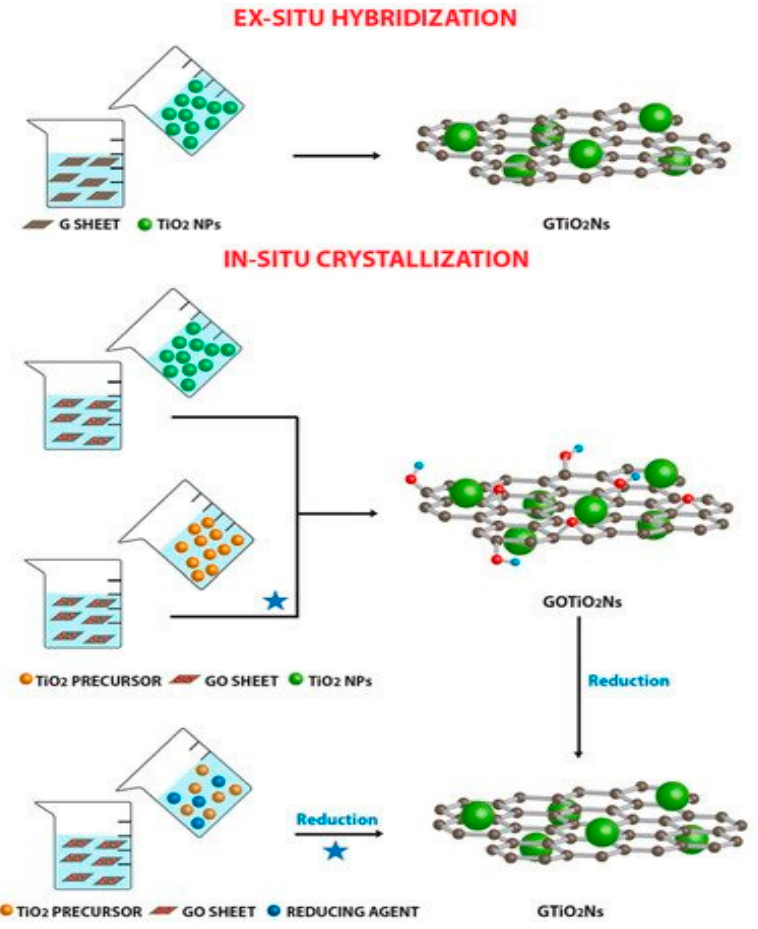
Figure 7. In-situ and Ex-situ compositing of metal salt with graphene and graphene derivatives. Reproduced with permission from Giovannetti, et al. [108] under Creative Commons Attribution 4.0 International.